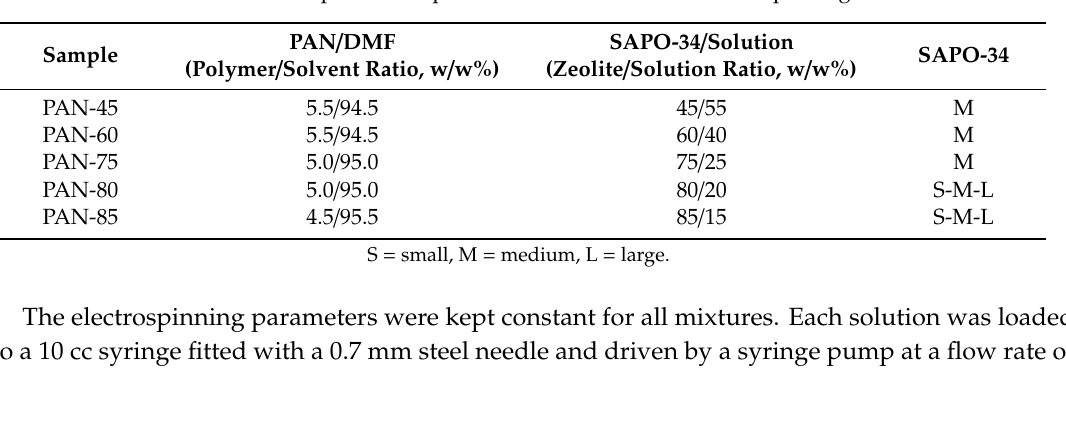
Table 1. Composition of precursor solutions before